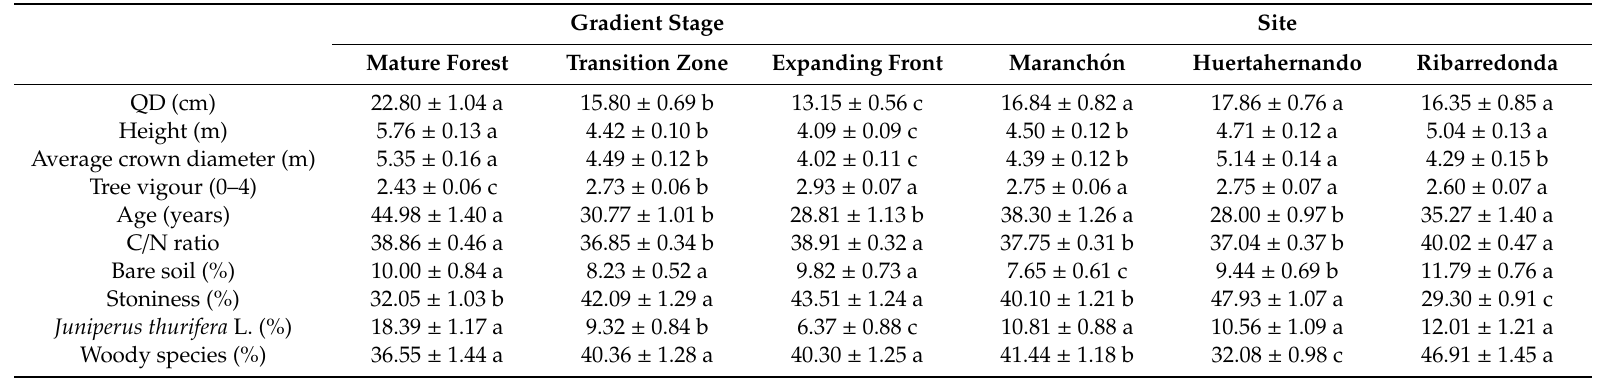
Table 1. Mean ± SE of each variable studied for each stage of the expansion gradient and for each study site (values for each site are the mean of each variable studied for all plots located in each site). QD (quadratic diameter); di ff erent letters indicate significant di ff erences ( p <